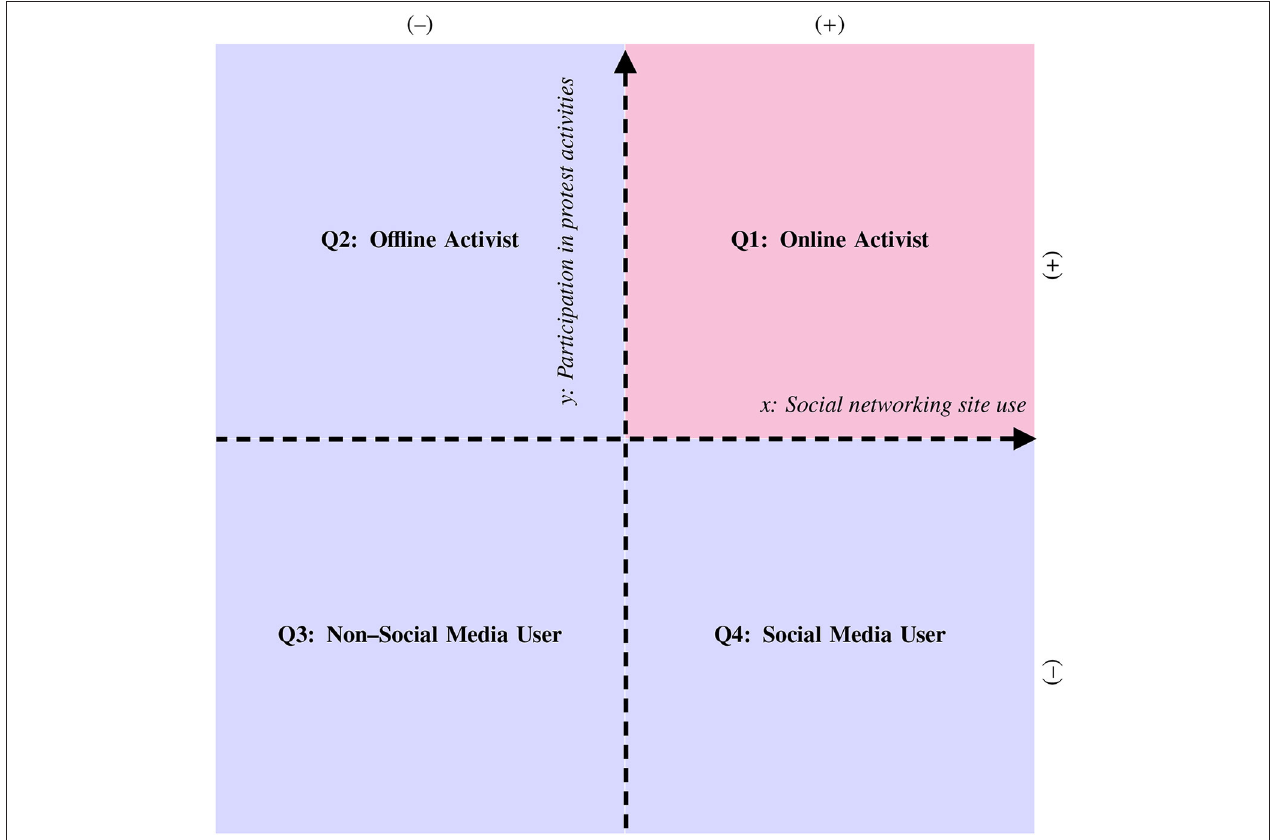
FIGURE 1 | Idealized typology of individuals based on the hypothetical relationship between social networking site use ( x ) and protest activity participation ( y ).